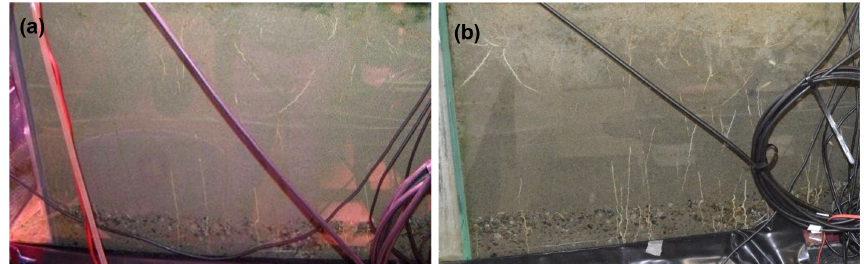
Figure 6. Front view photograph of the root system in the vegetated part of the model constructed wetland: (a) before the first run and (b) at the end of the second